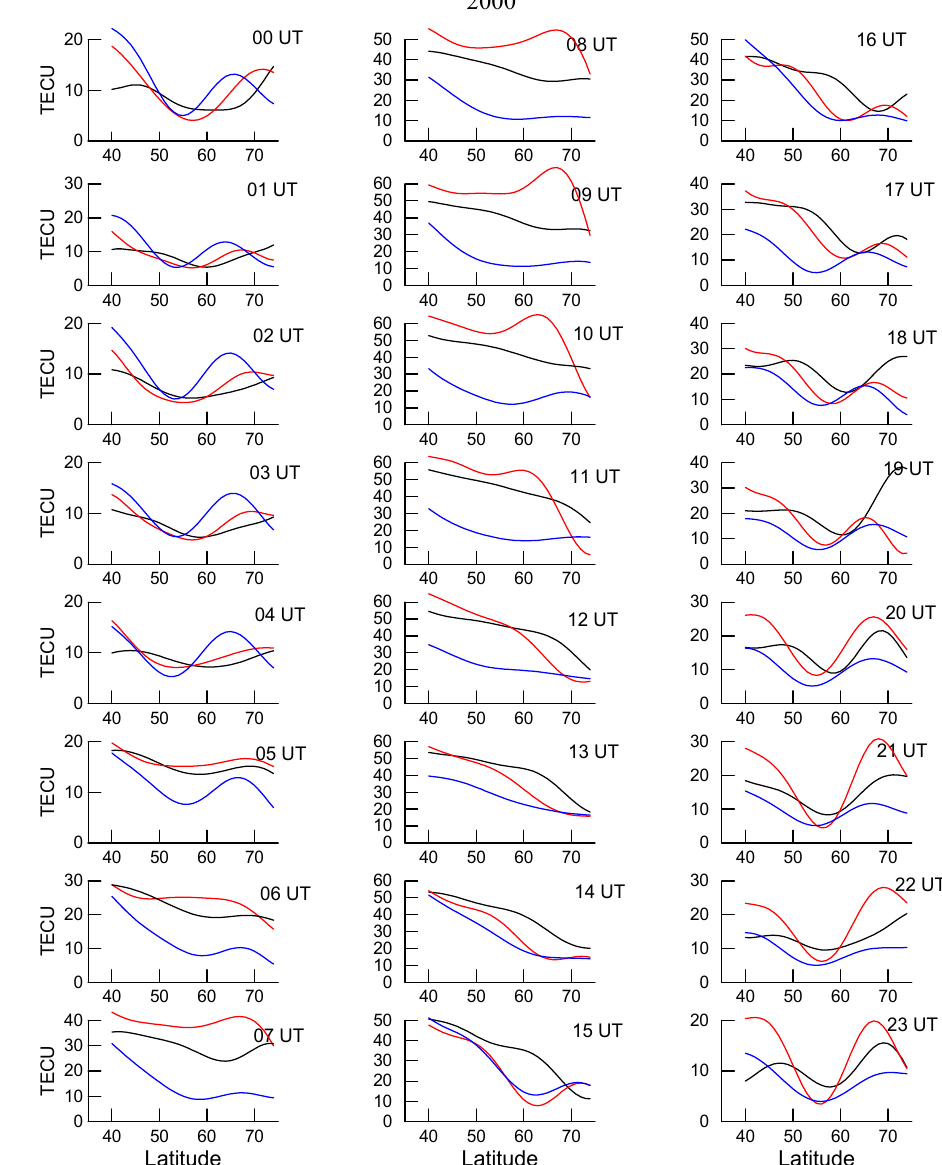
Fig. 5 Latitudinal TEC profiles over Europe at longitude 20o E. Black line – 2 October, ∑ Kp=16, Fig. 5. Latitudinal TEC profiles over Europe at longitude 20 ◦ E. Black line – 2 October, P K p = 16, red line – 4 October, P K p = 40, red line – 4 October, ∑ Kp=40, blue line – 5 October, ∑ Kp=53 . blue line – 5 October, P K p =